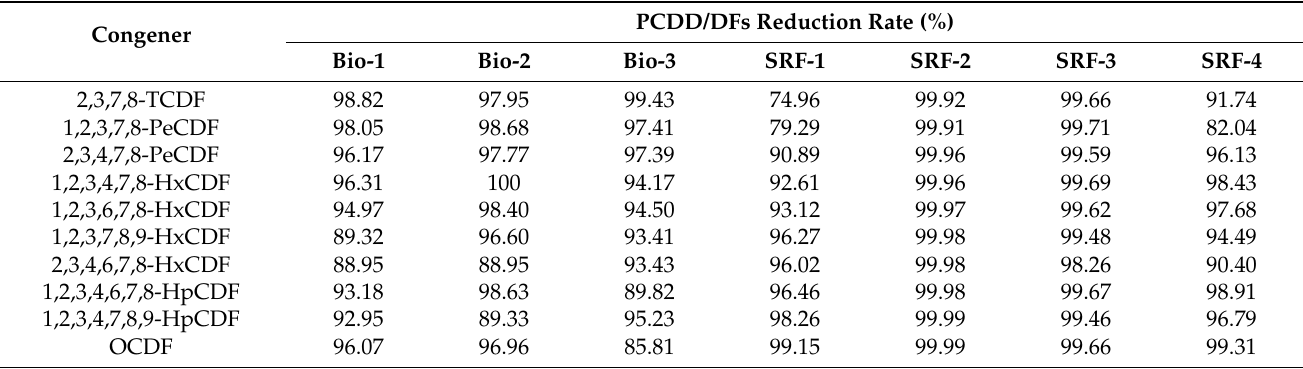
Table 6. Reduction rate of PCDD/DFs concentration between WHB and